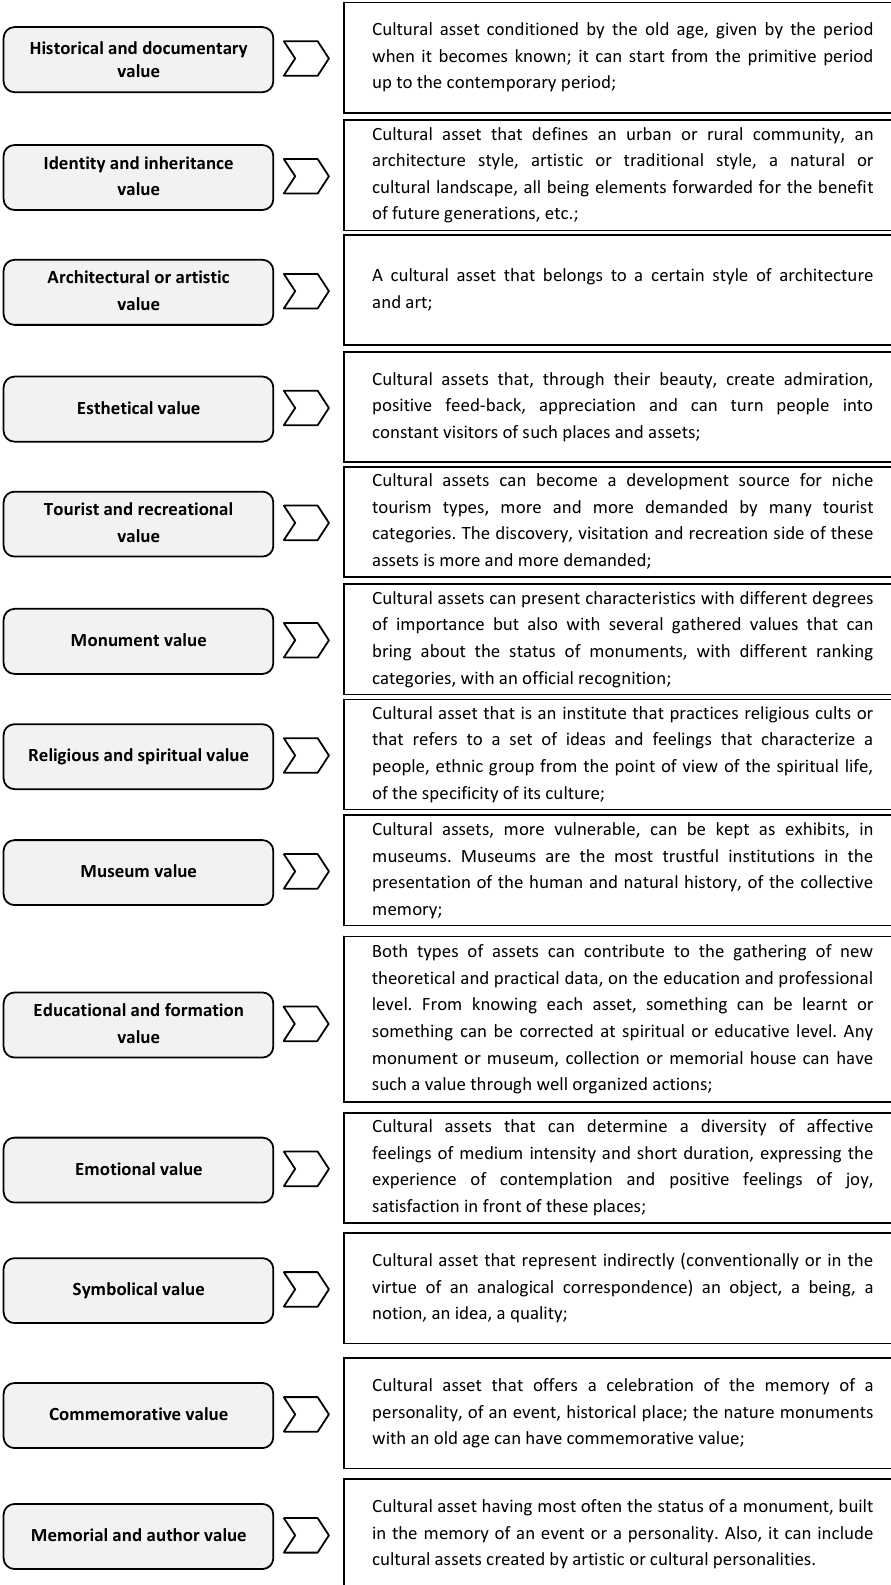
Figure 5. The set of values used as evaluation criteria for cultural heritage components. Source: Bogan et al., 2021 [56].